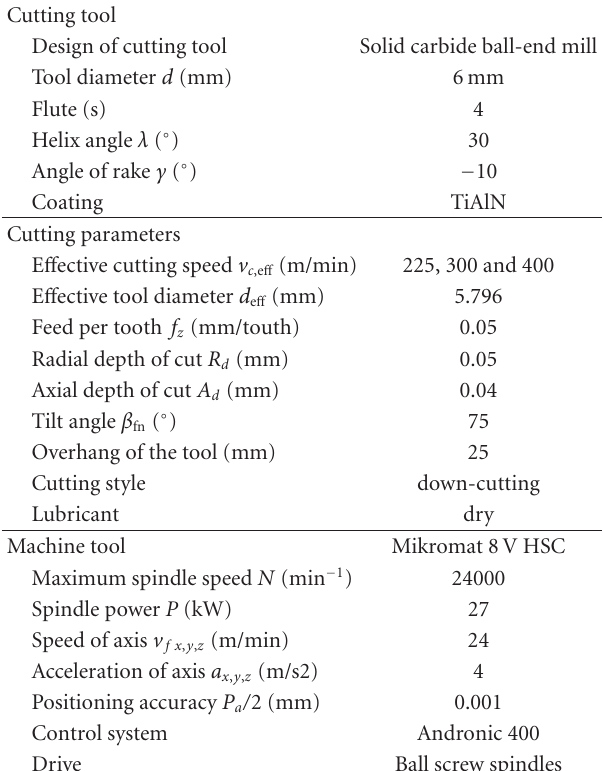
Table 1: Experimental